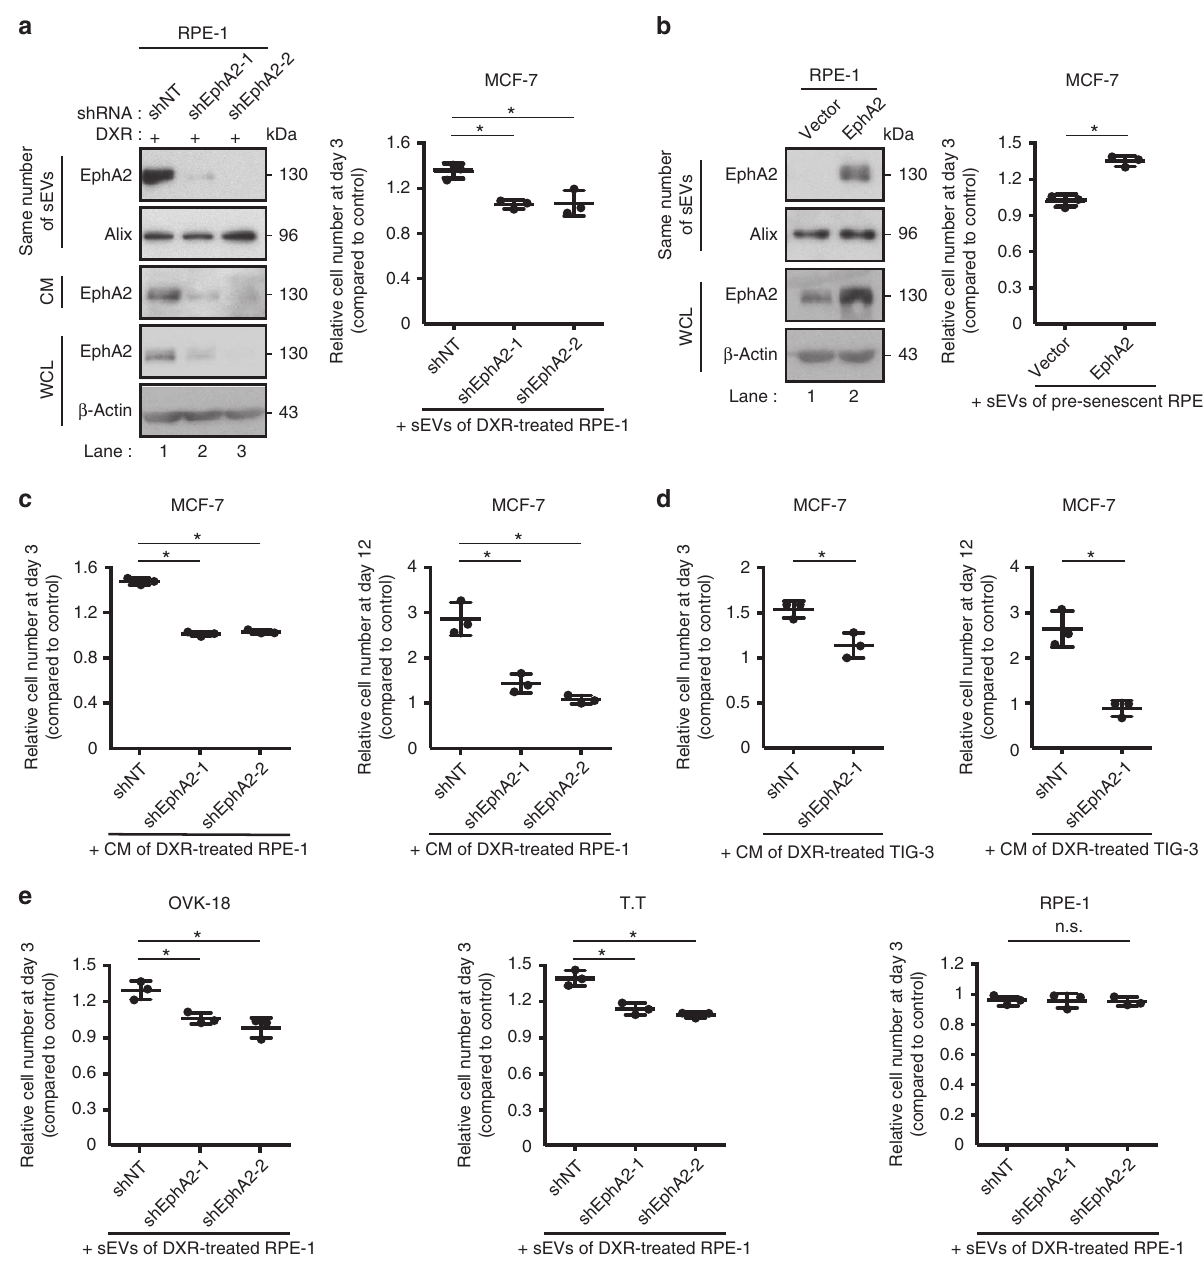
Figure 4 | sEV-associated EphA2 promotes cancer cell proliferation. ( a ) Immunoblotting shows successful knockdown of EphA2 in DXR-induced senescent RPE-1 cells. The same number of sEVs was loaded in each lane. Dot plot represents the relative numbers of MCF-7 cells grown for 3 days in the presence of sEVs compared with the number of cells grown for 3 days in normal medium. sEVs were purified from DXR-induced senescent RPE-1 cells expressing non-targeting shRNA (shNT) or EphA2 shRNA (shEphA2-1 or shEphA2-2) and added to the medium at a concentration of 2 (cid:2) 10 9 particles per ml. ( b ) Immunoblotting shows successful overexpression of EphA2 in pre-senescent RPE-1 cells. The same number of sEVs was loaded in each lane. Dot plot represents the relative numbers of MCF-7 cells grown for 3 days in the presence of sEVs compared with the number of cells grown for 3 days in normal medium. sEVs were purified from pre-senescent RPE-1 cells expressing empty vector or ectopic EphA2, and added to the medium at a concentration of 2 (cid:2) 10 9 particles per ml. ( c , d ) Relative numbers of MCF-7 cells grown for 3 and 12 days in the presence of CM prepared from ( c ) DXR-induced senescent